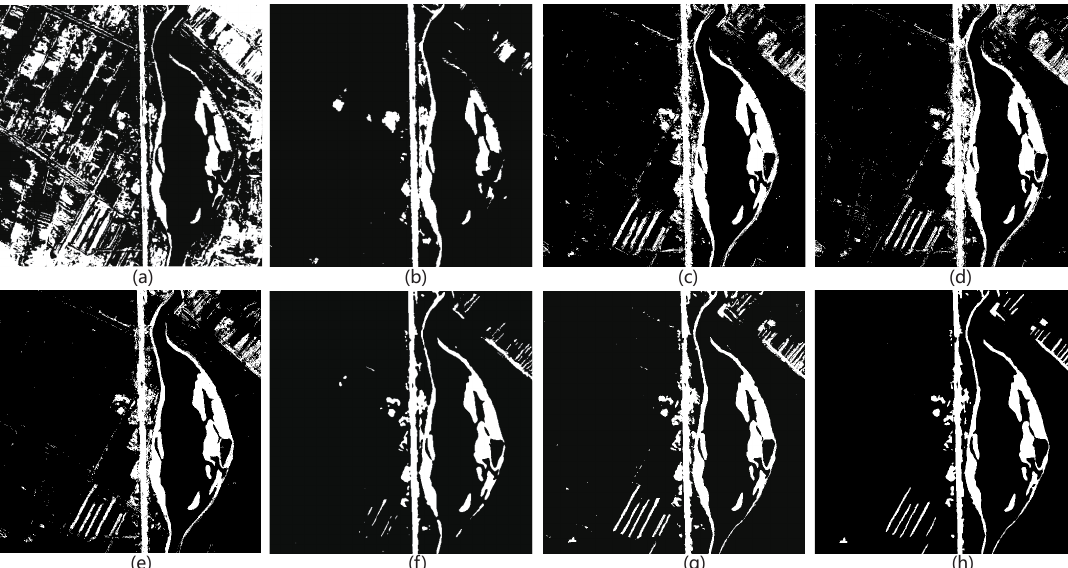
Figure 11. Binary change maps of Hongqi data set. ( a ) CVA. ( b ) IRMAD. ( c ) SCCN. ( d ) S-CNN+Threhold. ( e ) S-CNN+SVM. ( f ) SRDL. ( g ) Our proposed SSJLN. ( h ) Ground truth. The unchanged samples are black and changed samples are